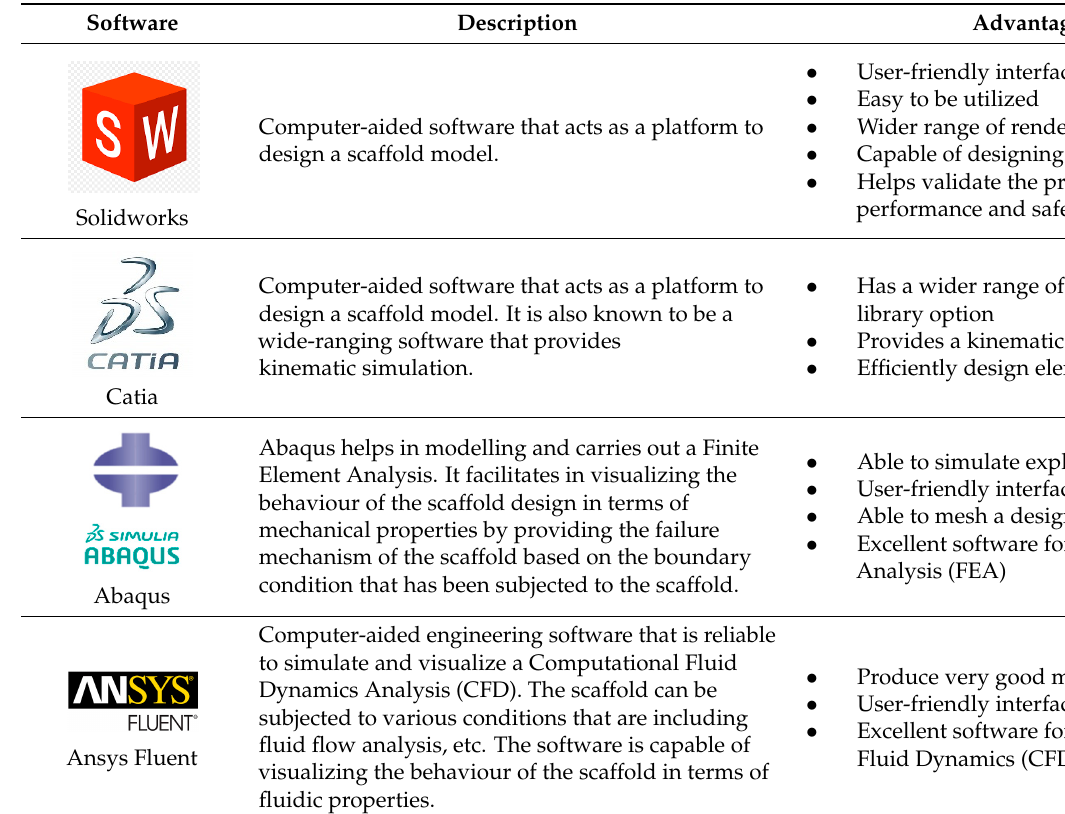
Table 5. Commonly Used Software for Tissue Engineering Scaffold Simulation.